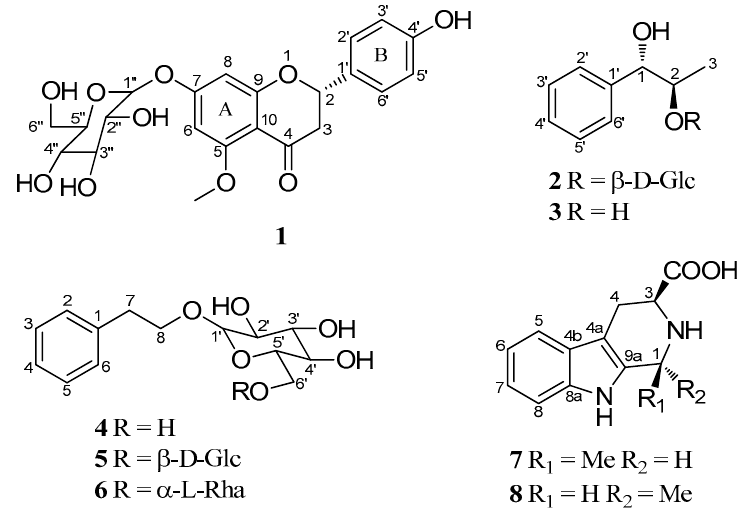
Figure 1. Chemical structures of compounds 1 – 8 .